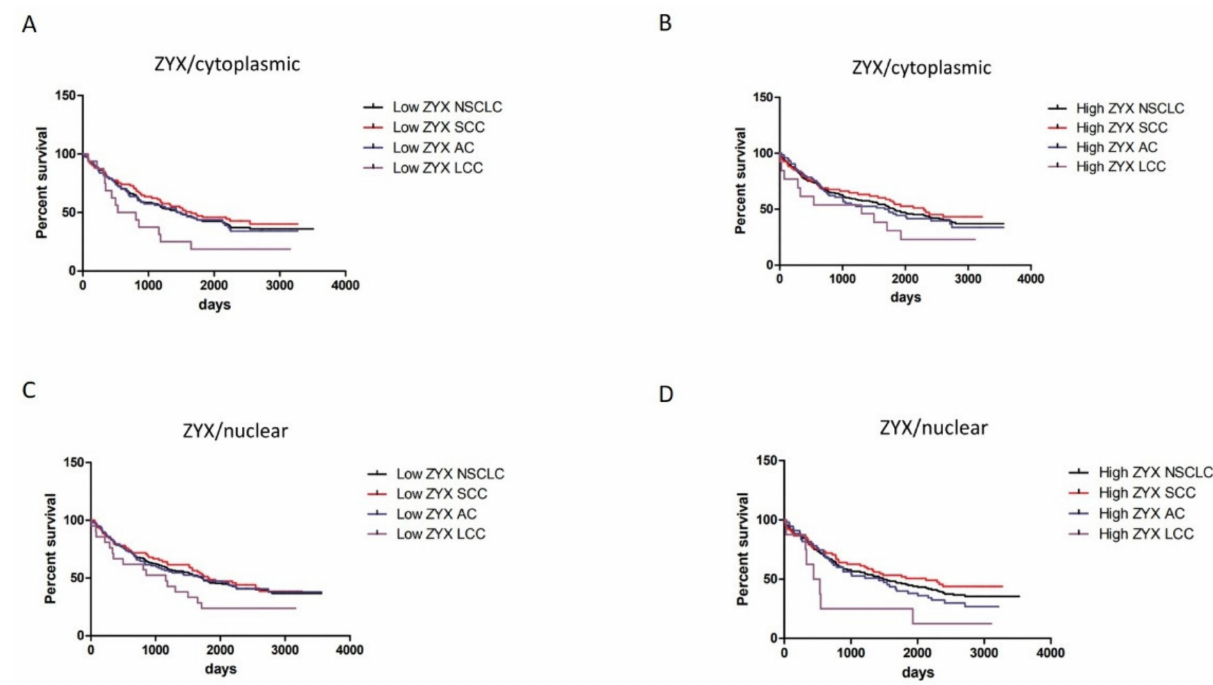
Figure 13. Different cytoplasmic ( A , B ) and nuclear ( C , D ) ZYX expression statuses in relation to survival of NSCLC (total), SCC, AC, and LCC patients. The cut-off points were set on median values of ZYX expression in NSCLC, SCC, AC, and LCC